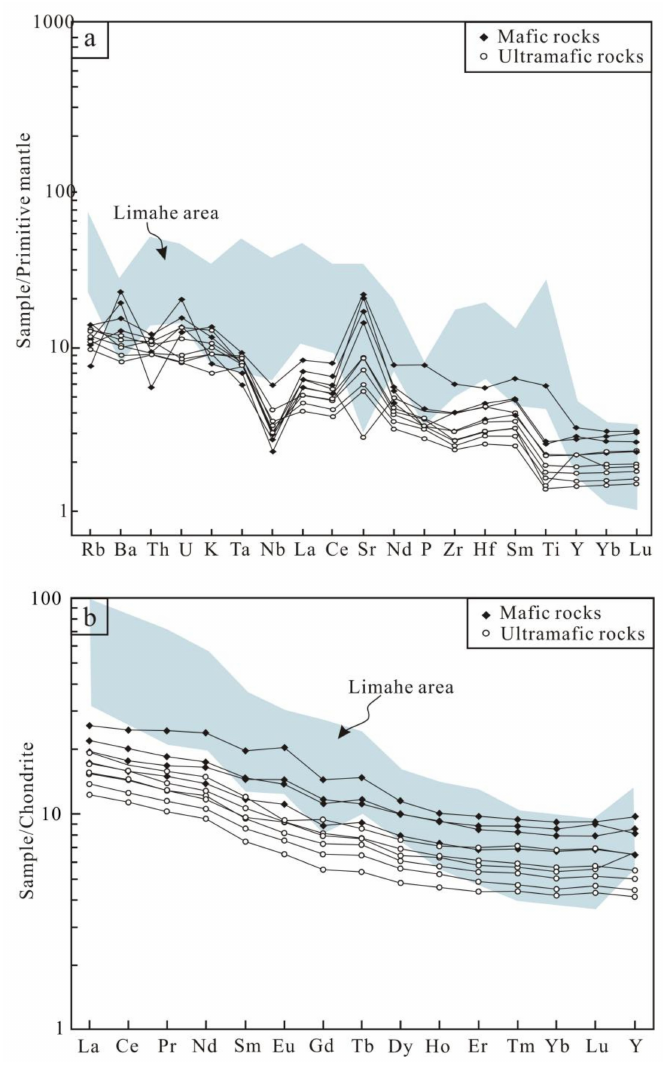
Figure 5. ( a ) Primitive mantle normalized incompatible trace element spider diagram; ( b ) Chondrite- normalized REE patterns for samples from the Baixintan and Limahe intrusions. Data sources of Limahe (25 samples): [80,81]. The primitive mantle values and chondrite values are from